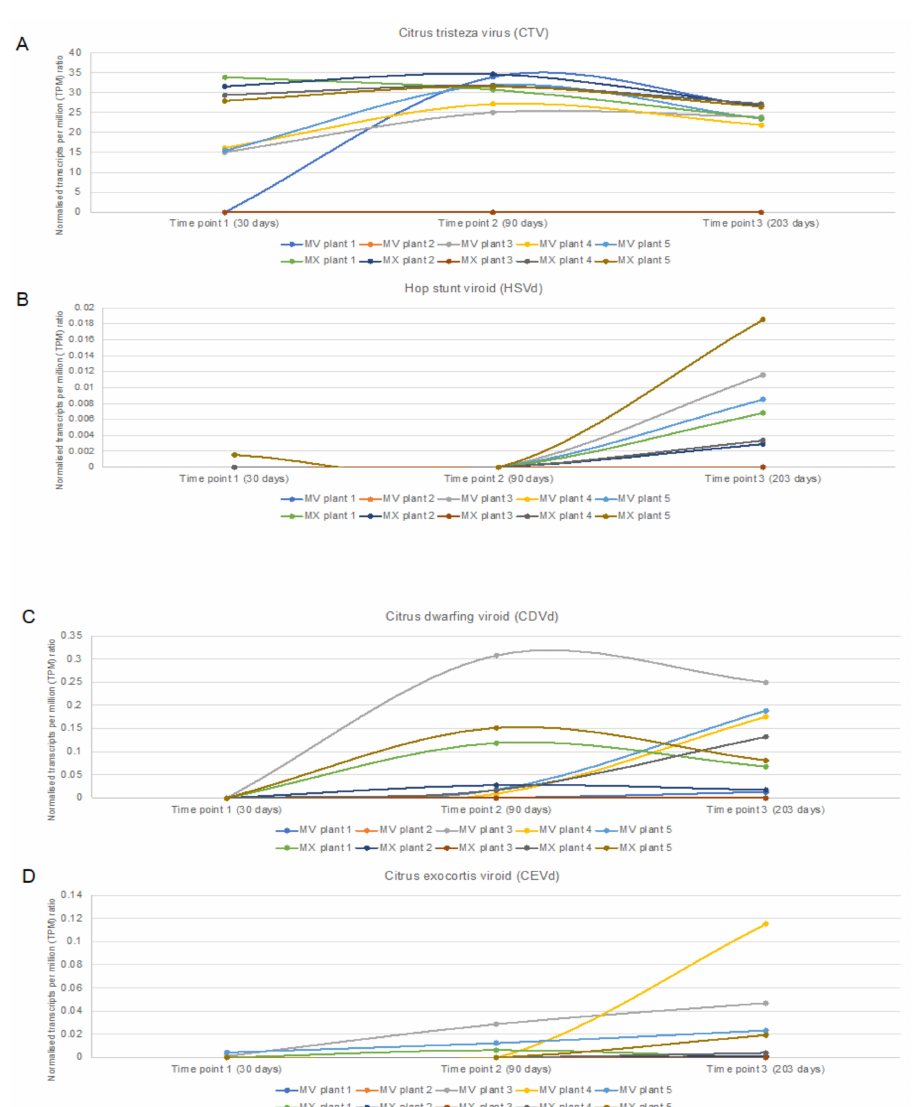
Figure 5. Line diagram displaying the relative pathogen concentration (normalized transcripts per million (TPM) ratio) from time point 0 (0 days post inoculation) to time point 3 (203 days post inoculation) for citrus tristeza virus (CTV) ( A ), Hop stunt viroid (HSVd) ( B ), citrus dwarfing viroid (CDVd) ( C ), and citrus exocortis viroid (CEVd) ( D ). Five plants per cultivar were evaluated (MV: ‘Madam Vinous’; MX: ‘Mexican Lime’).